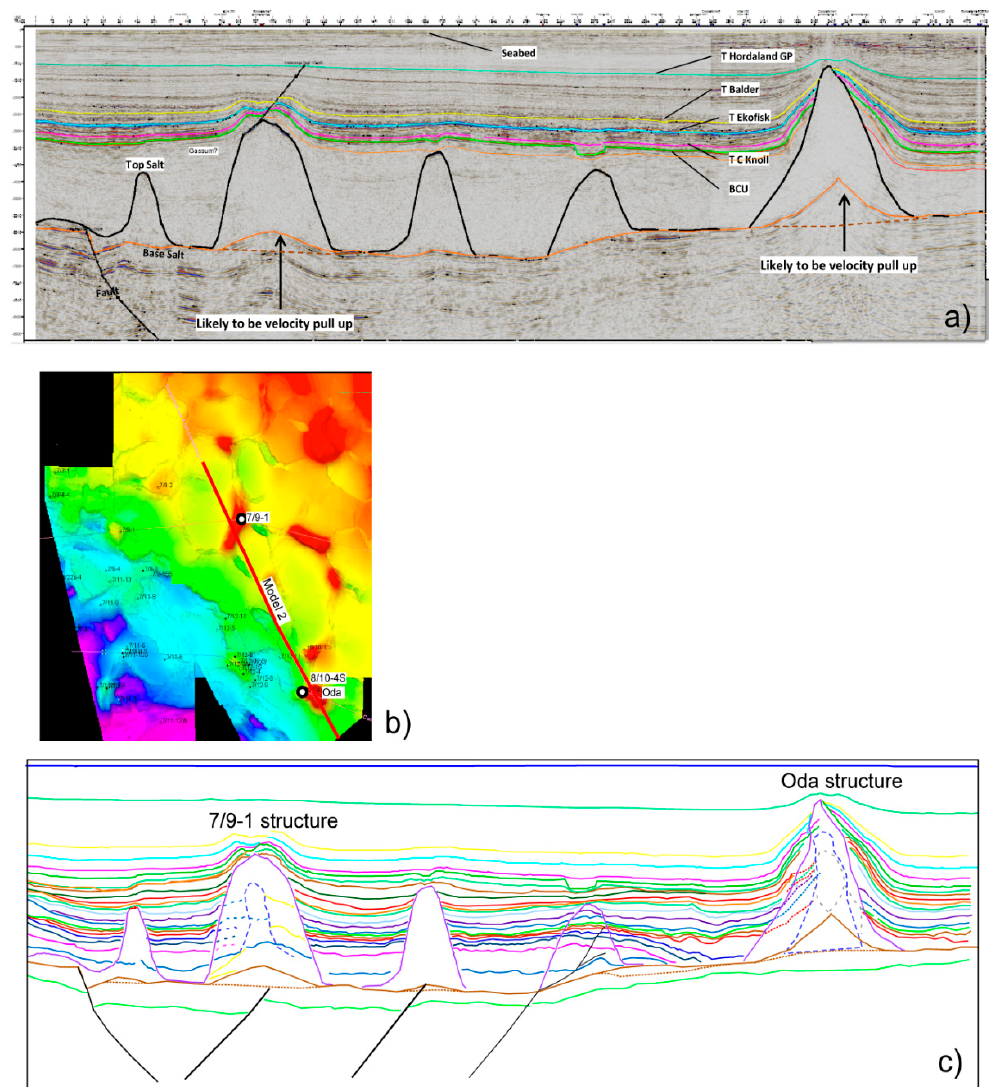
Figure 12. Interpretation of present-day structures on Model 2. ( a ) Interpreted depth-converted seismic section. b ) Map of Base Cretaceous horizon with the position of the modeled profile. c )